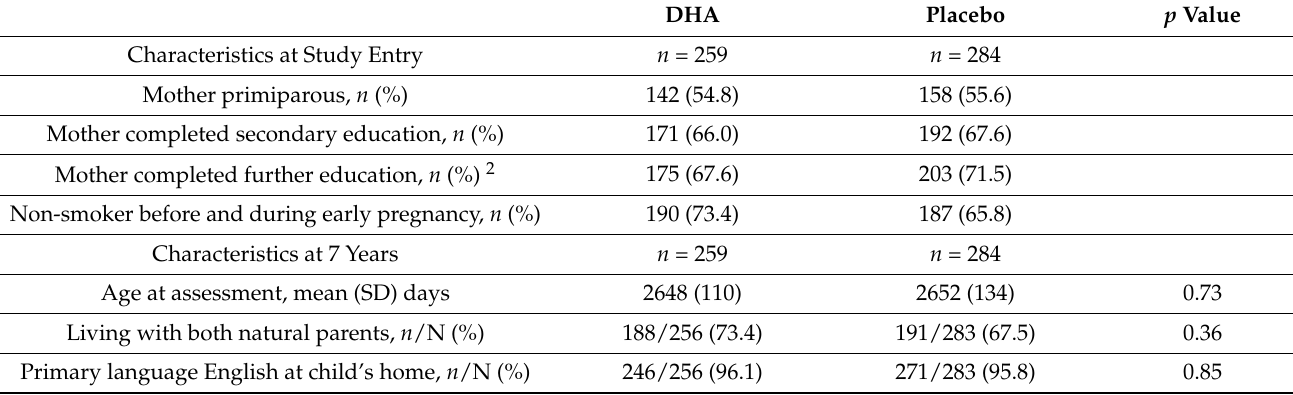
Table 1. Treatment group comparison of baseline and post-randomization demographic, social, and clinical characteristics 1 . DHA Placebo p Value Characteristics at Study